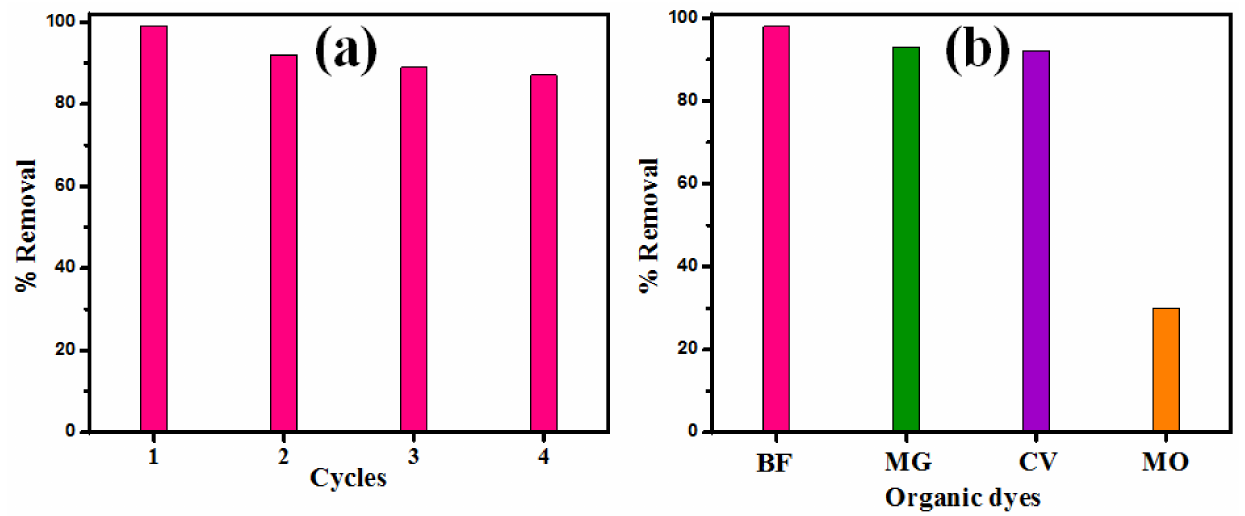
Figure 8. ( a ) Reusability efficiency of MgO NPs and ( b ) the elimination rate of different dyes by MgO